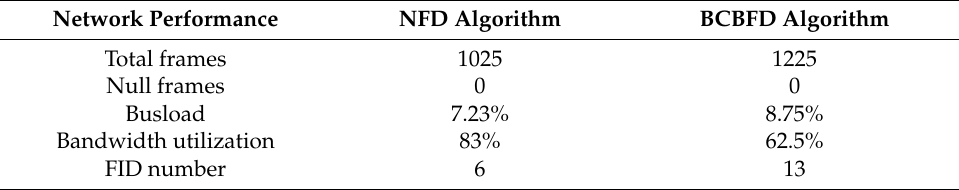
Figure 10. The node set of FlexRay simulation system. Table 8. Network performance Table 5. FlexRay network signal set.